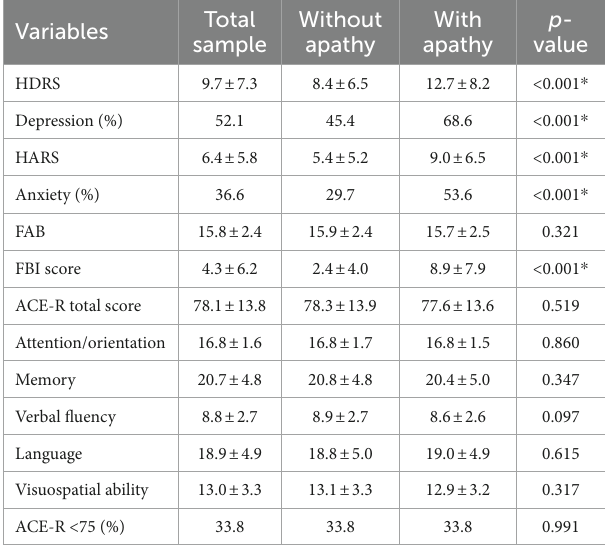
TABLE 2 Cognitive function and health-related quality of life of ALS patients in different subgroups.